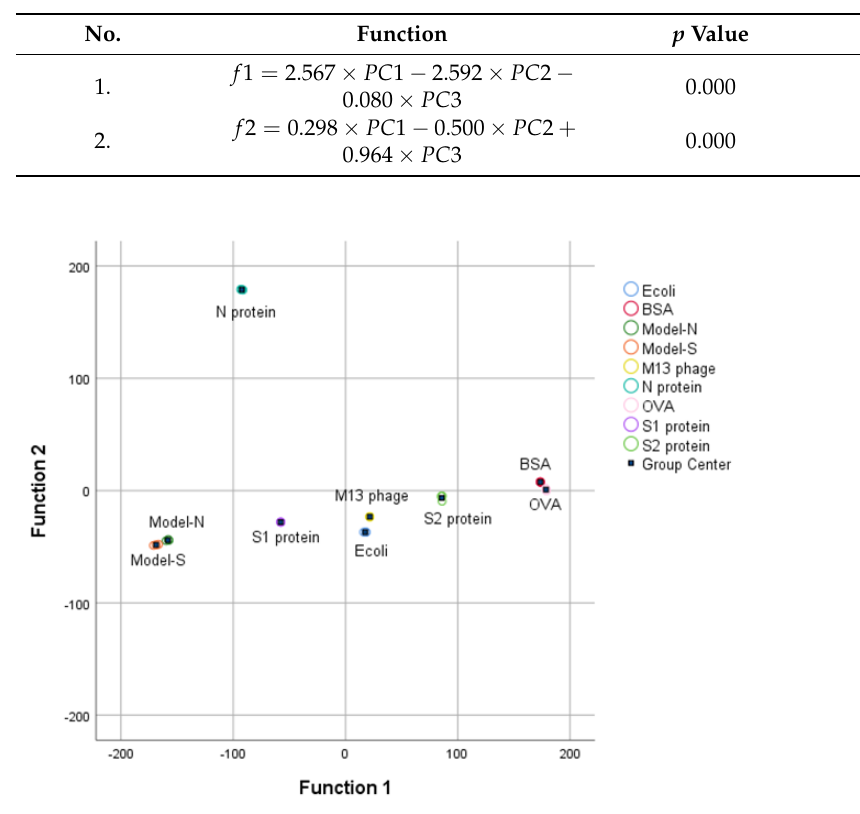
Table 6. Derived functions and validation from LDA analysis for RS.